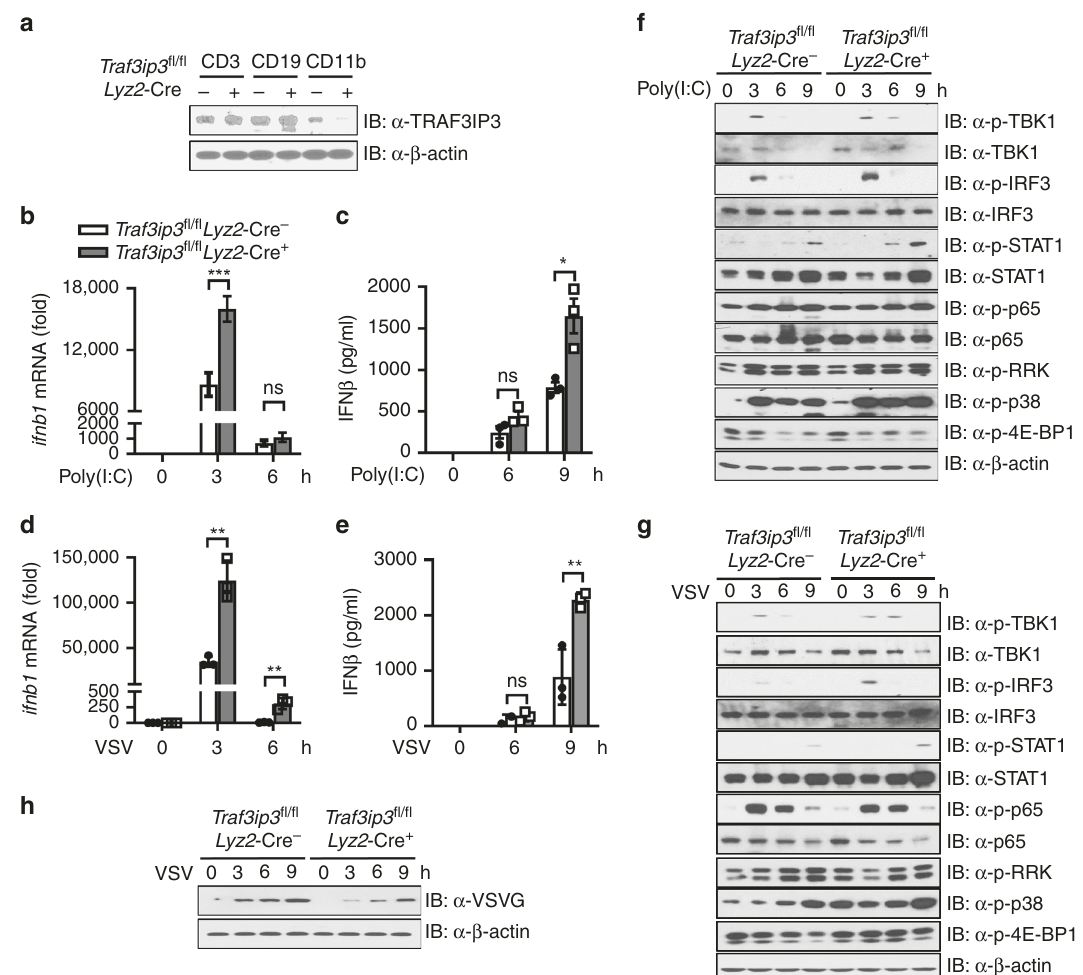
Fig. 3 Traf3ip3 de fi ciency potentiates the type I interferon response. a Immunoblotting of fl ow sorted CD3 + T cells, CD19 + B cells and CD11b + myeloid cells from indicated mice. b RT-PCR analysis and c IFN- β ELISA using Traf3ip3 fl / fl Lyz2 -Cre − and Traf3ip3 fl / fl Lyz2 -Cre + BMDMs transfected with poly(I:C) for the indicated times. RT-PCR data were normalized to Actb mRNA. d RT-PCR analysis and e IFN- β ELISA using Traf3ip3 fl / fl Lyz2 -Cre - and Traf3ip3 fl / fl Lyz2 -Cre + BMDMs infected with VSV (MOI = 1) for the indicated times. RT-PCR data were normalized to Actb mRNA. f , g Immunoblotting of signaling proteins using Traf3ip3 fl / fl Lyz2 -Cre − and Traf3ip3 fl / fl Lyz2 -Cre + BMDMs transfected with poly(I:C) ( f ) or infected with VSV (MOI = 1) ( g ) for the indicated time. Densitometry shown in Supplementary Fig. 6a and b. h Immunoblotting of VSVG using Traf3ip3 fl / fl Lyz2 -Cre - and Traf3ip3 fl / fl Lyz2 -Cre + BMDMs infected with VSV (MOI = 2) for the indicated time. Densitometry shown in Supplementary Fig. 6c. Data are presented as mean ± SEM and are one representative of three independent experiments. b – e n = 3 biologically independent animals, t -test. ∗ p < 0.05, ∗∗ p < 0.01, ∗∗∗ p < 0.001. ns, not signi fi cant. Source data are provided as a Source Data fi